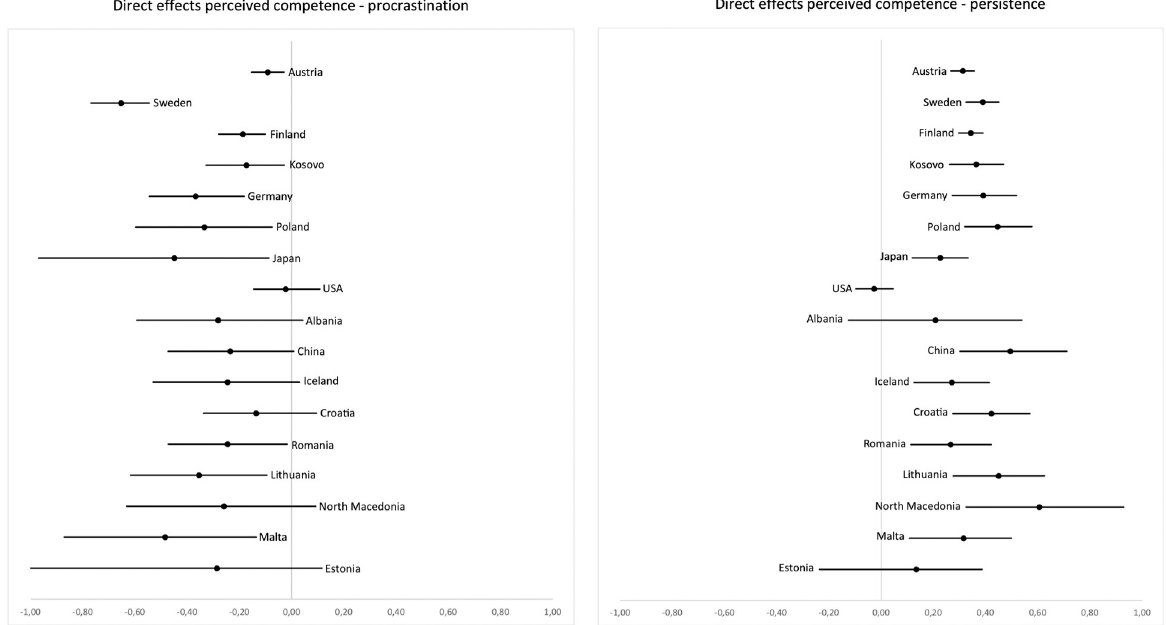
Fig 3. Unstandardized coefficients and two-sided 5% confidence intervals for the direct effects of perceived competence on procrastination (left) and persistence (right). Countries are ordered by sample size from top (highest) to bottom (lowest).